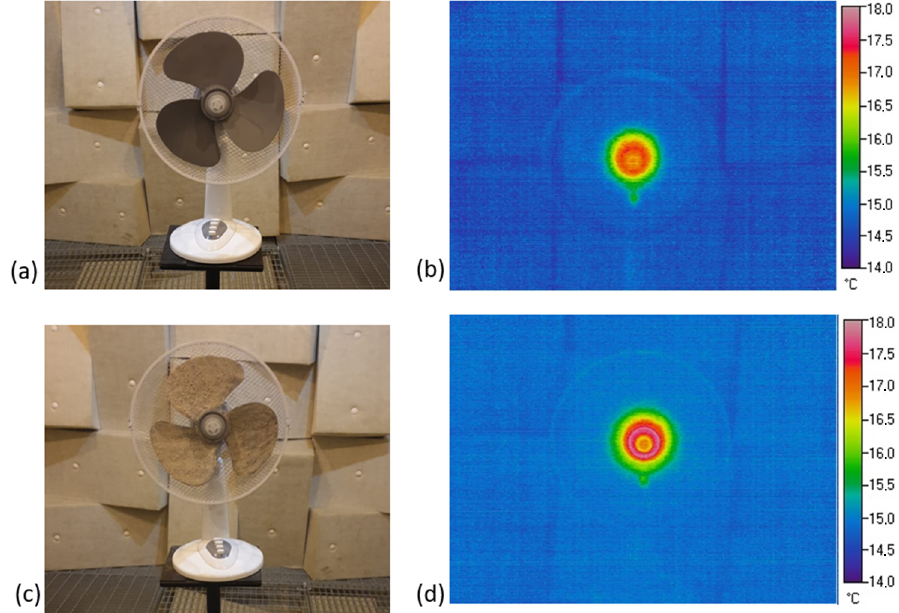
Figure 7. Axial fan in the two operating conditions; ( a ) No-Fault: the fan blades are perfectly clean and there are no accumulations of material on the surface; ( b ) Thermal image of the fan in No-Fault operating conditions; ( c ) Fault: there are deposits of artificially created material on the fan blades; ( b ) Thermal image of the fan in Fault operating conditions.